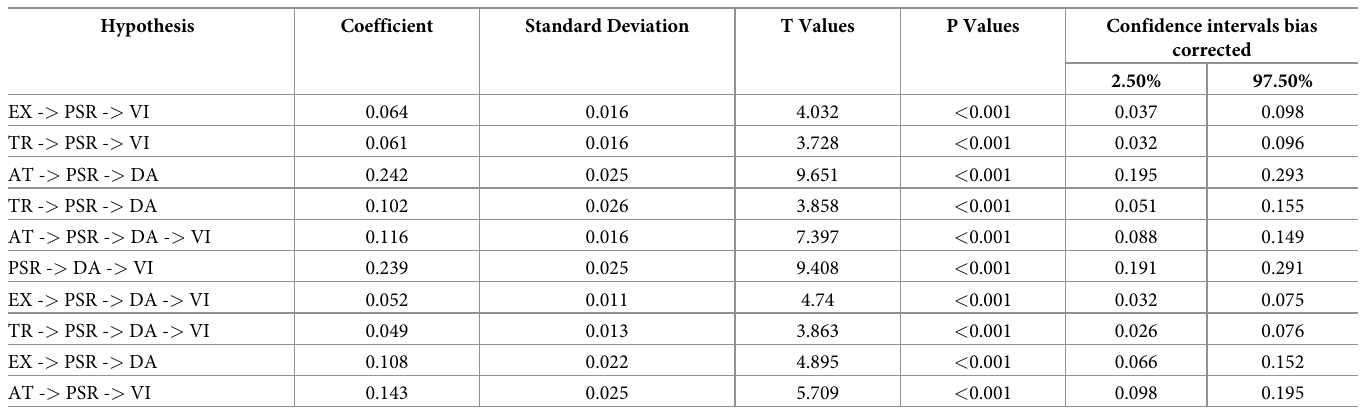
Table 6. Mediation tests